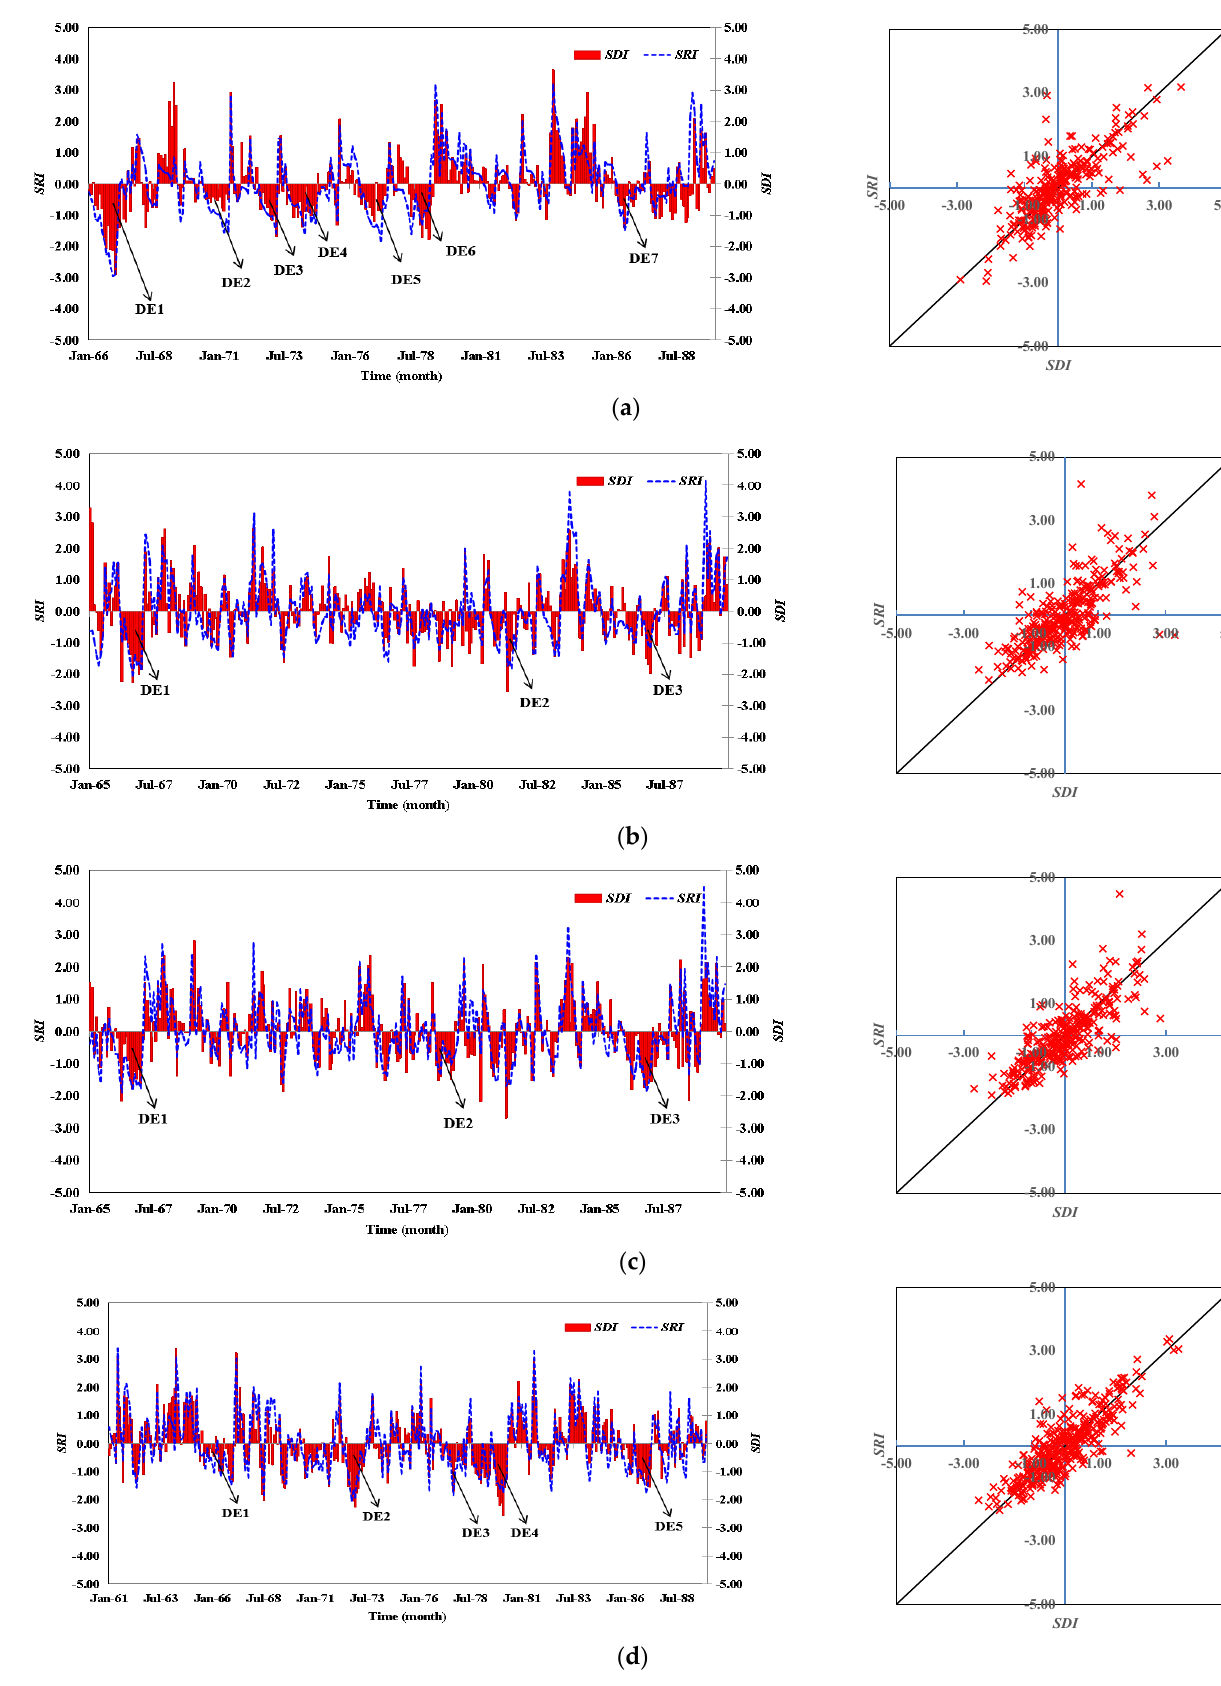
Figure 4. Standardized hydrological index series calculated from simulated runoff (SRI) and observed streamflow (SDI) at: ( a ) Sheqi; ( b ) Taikou; ( c ) Wanyugou; ( d ) Youshuijie.